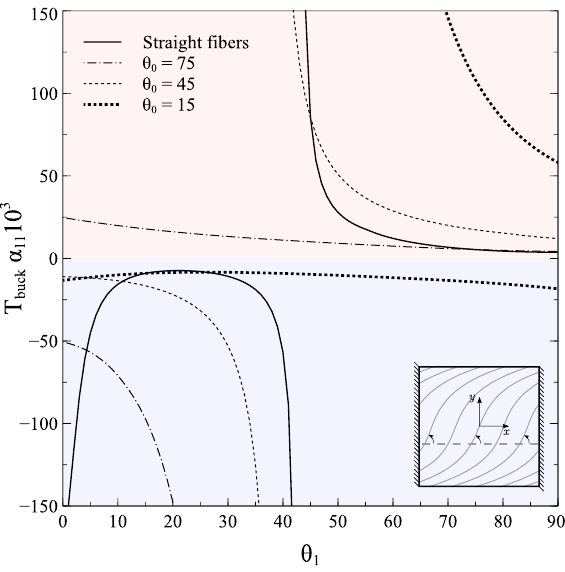
Figure 8. Buckling design charts for different SSSS variable-stiffness configurations, b / h